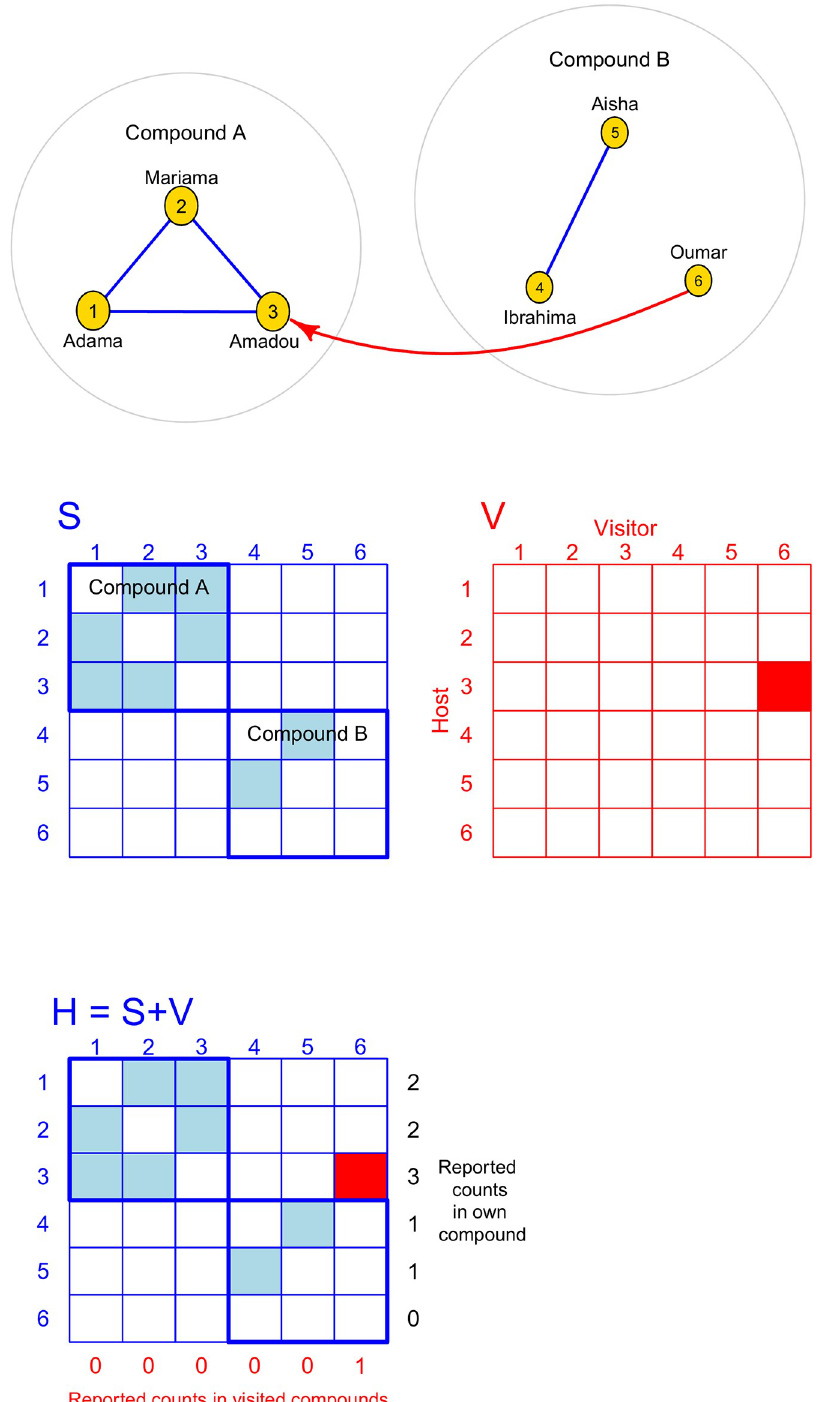
Fig 2. Toy example of a social network with adjacency matrices: S represents contacts between members of the same compound, V represents contacts between members of different compounds, and H = S + V has row sums equal to the numbers of contacts reported in the respondent’s